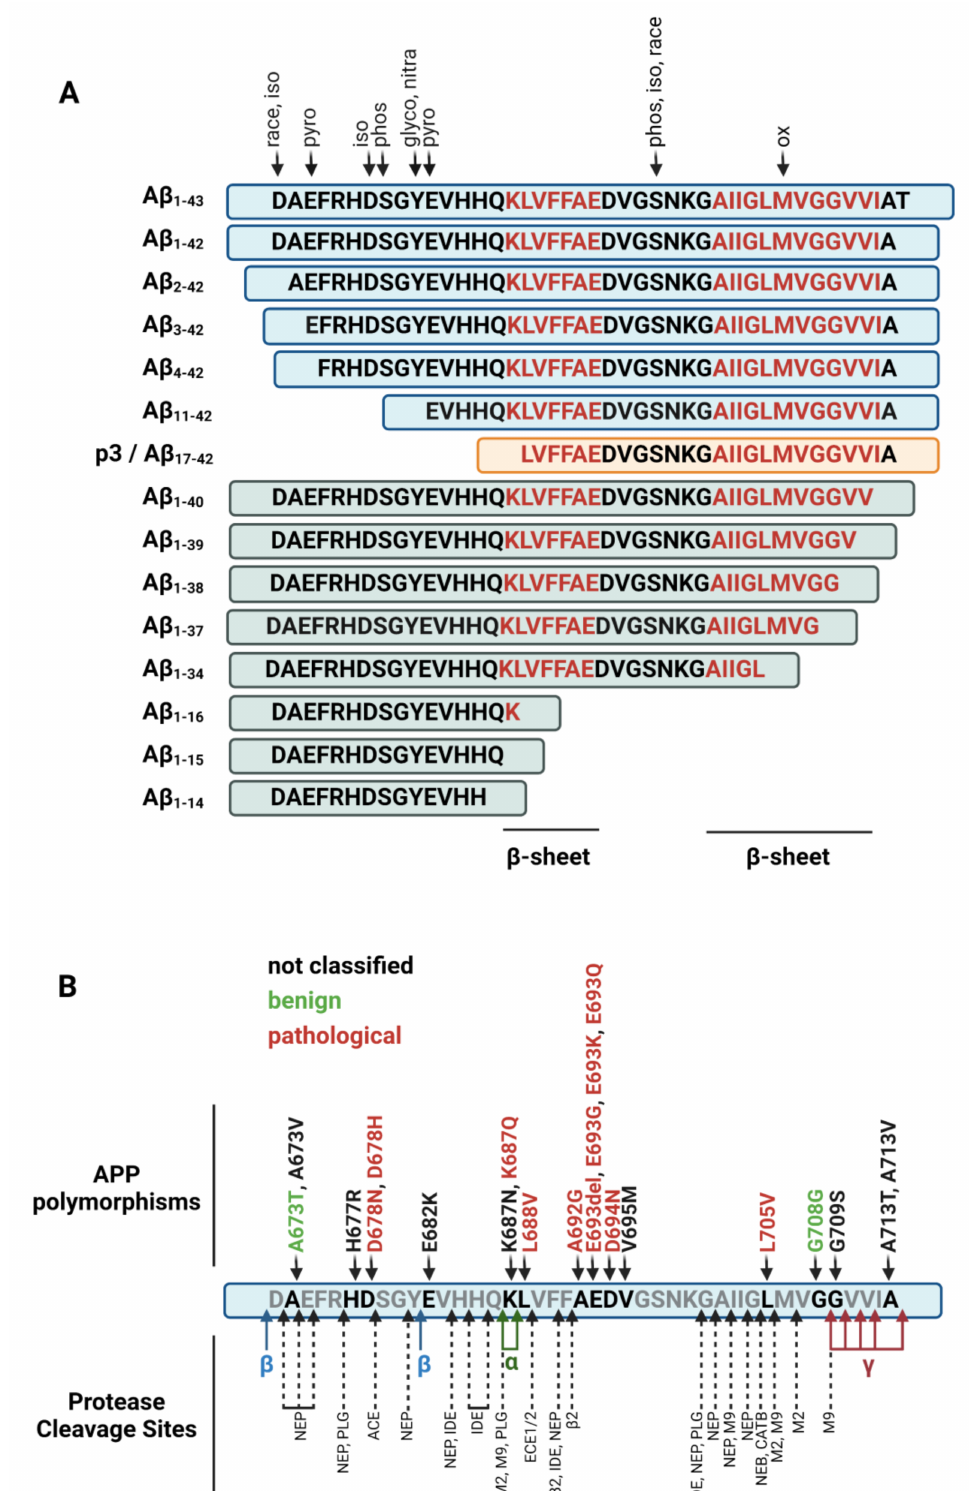
Figure 2. Truncated and modified A β species . ( A ): Depiction of N- and C-truncated A β variants and their potential modification sites as described in Kummer and Heneka, 2014. Motifs for β -sheet formation are indicated in red (race = racemization, iso = isomerization, pyro = pyroglutamylation, phos = phosphorylation, glycol = glycosylation, nitra = nitration, ox = oxidation). ( B ): A β peptide